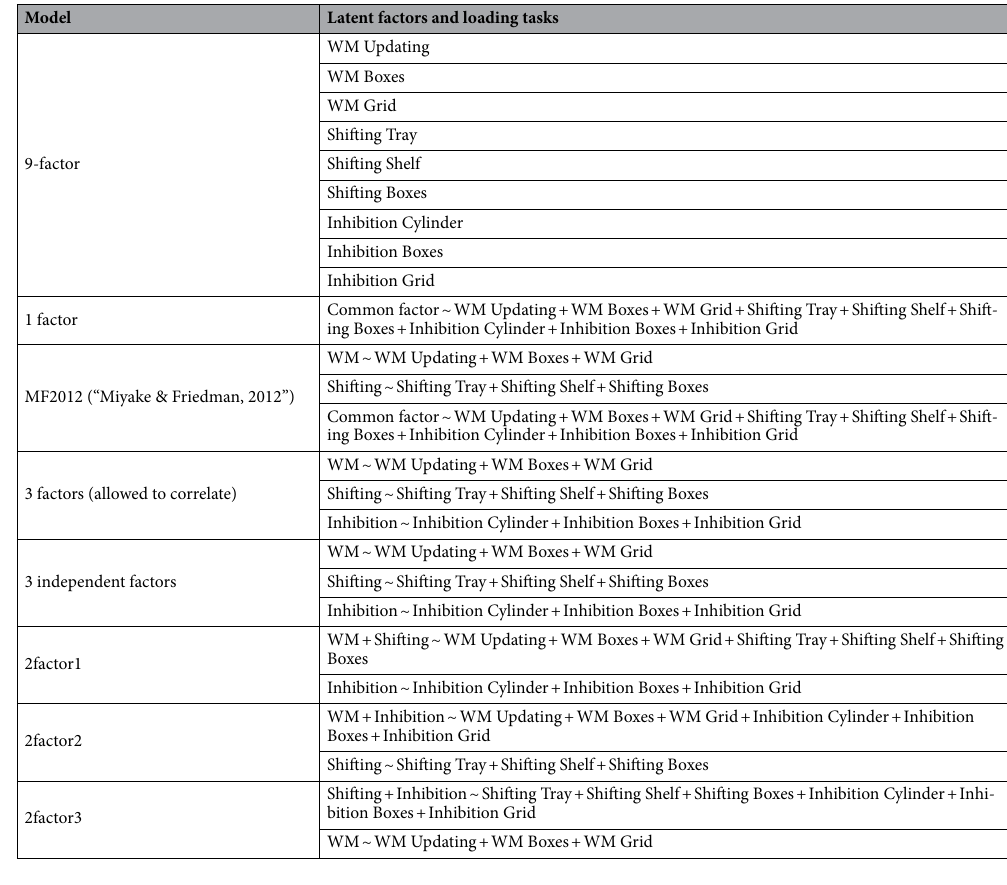
Table 4. Overview of the fitted CFA